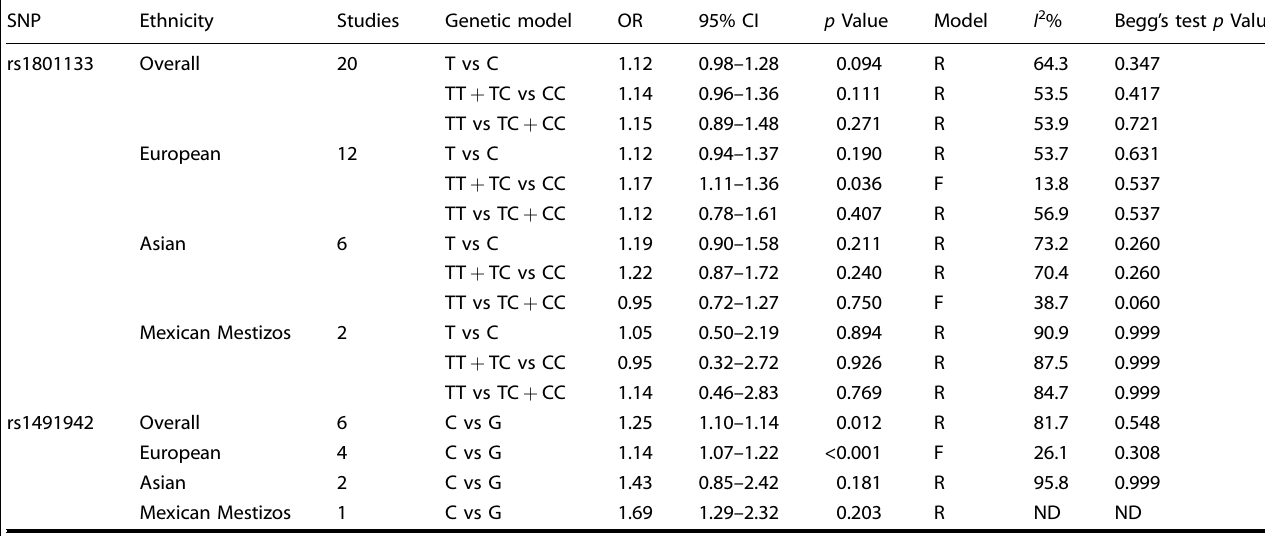
Table 4. Summary of